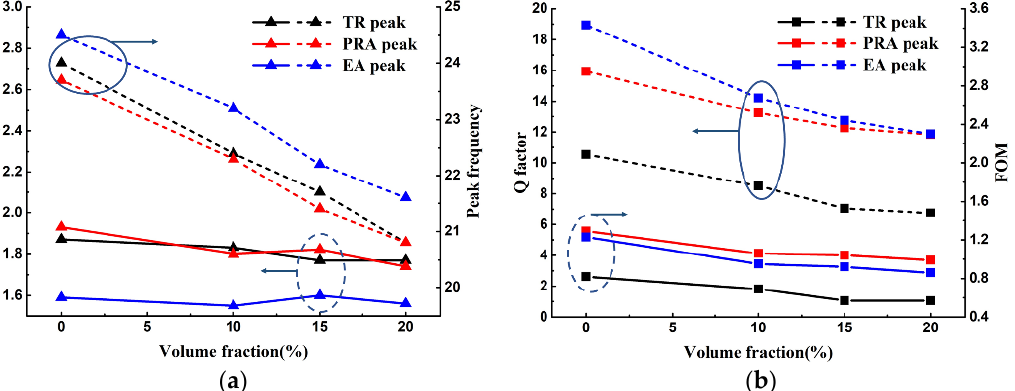
Figure 7. ( a ) Measured frequency shifts and sensitivity, and ( b ) Q factor and FOMs of TR, EA, and PRA peaks, varying with the volume fraction of